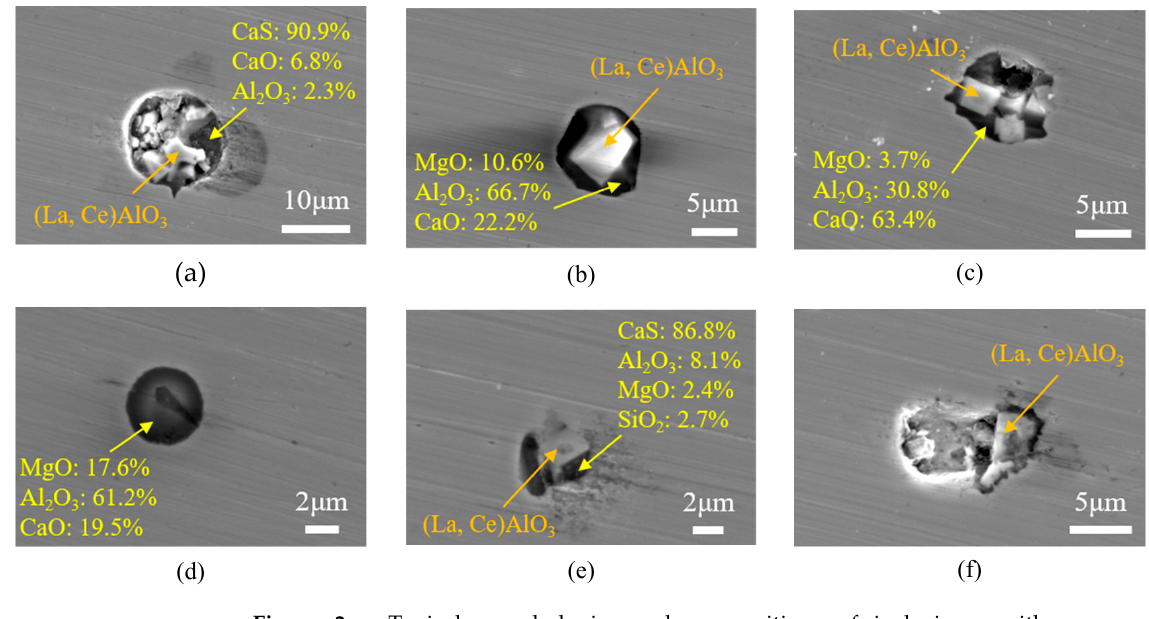
Figure 2. Typical morphologies and compositions of inclusions, with rare earth treatment. ( a ) (La,Ce)AlO 3 +Al 2 O 3 -CaO-CaS; ( b ) Inner layer: (La,Ce)AlO 3 , Outer layer:Al 2 O 3 -CaO-MgO; ( c ) (La,Ce)AlO 3 +Al 2 O 3 -CaO-MgO; ( d ) Al 2 O 3 -CaO-MgO; ( e ) (La,Ce)AlO 3 +Al 2 O 3 -MgO-CaS; ( f ) (La,Ce)AlO 3 .